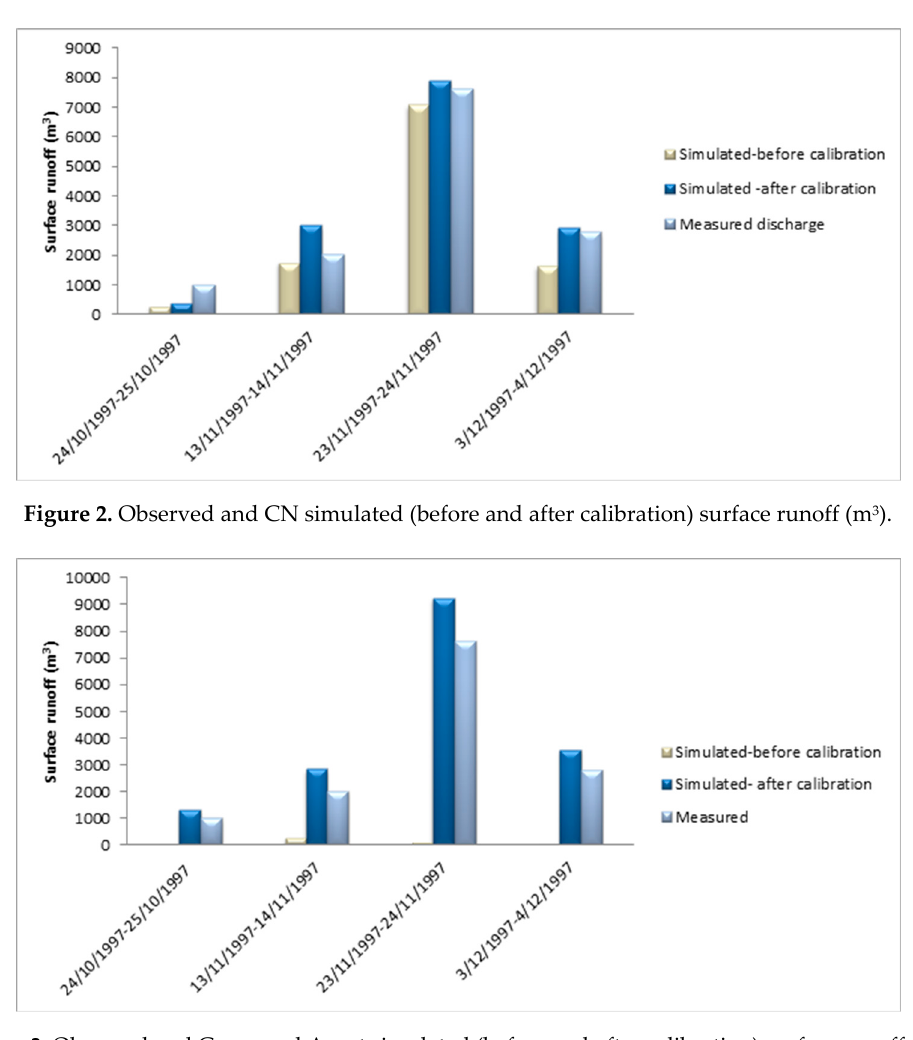
Figure 3. Observed and Green and Ampt simulated (before and after calibration) surface runoff (m 3